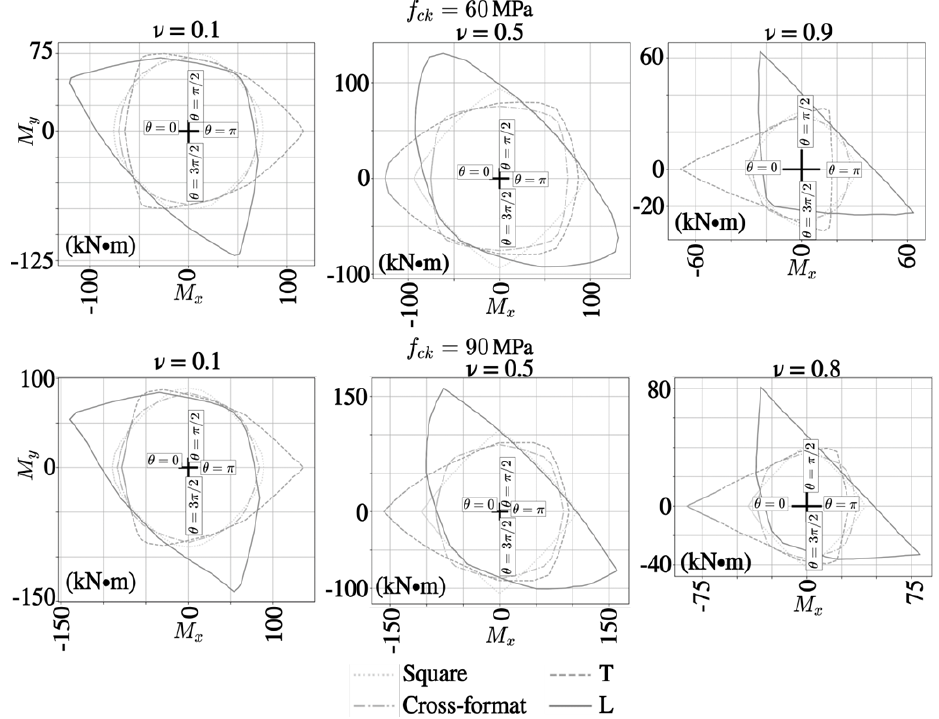
= 60 and 90 MPa. ck f